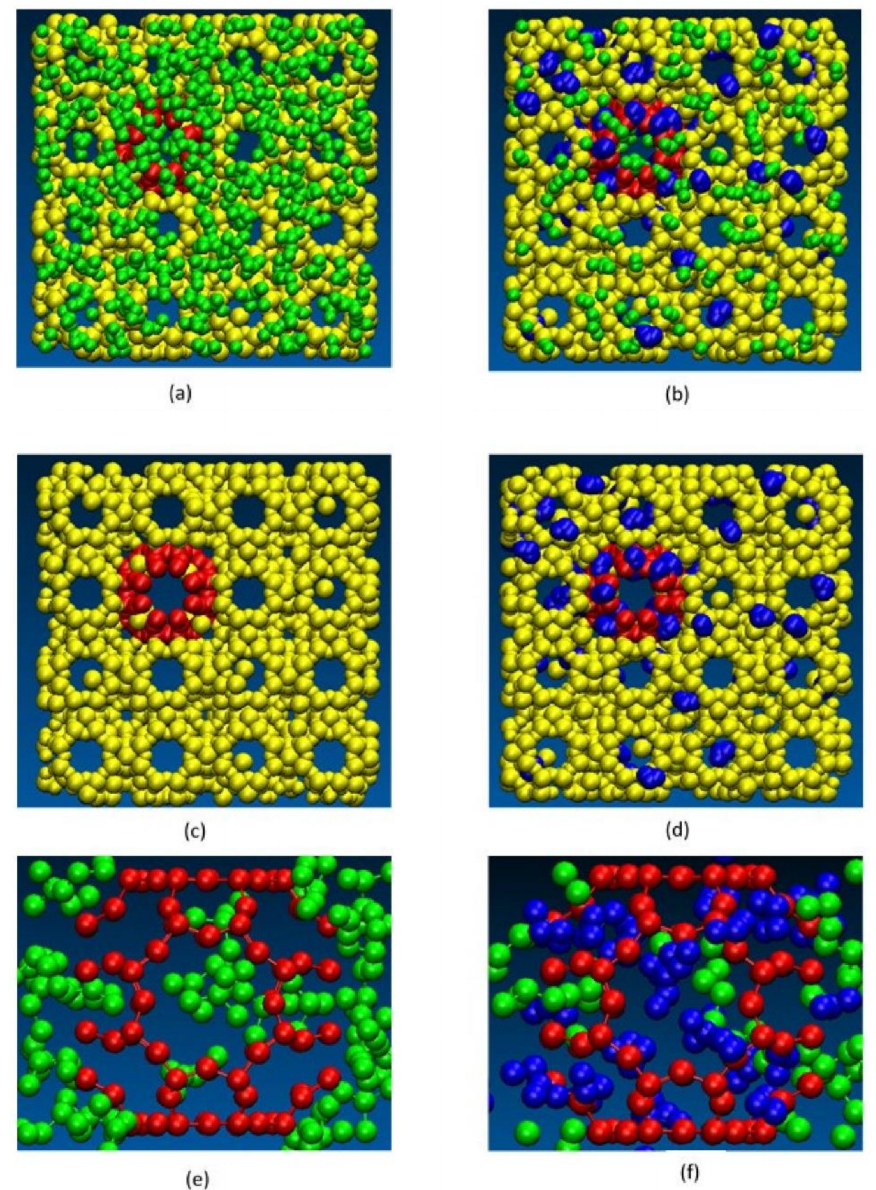
Figure 15. Changes in behavior observed in pure IPA (left side, a , c , e ) and 5 wt % water (right side, b , d , f ): axial snapshots of the membrane defect showing ( a ) pure IPA molecules permeating membrane defect and ( b ) water and IPA molecules blocking the membrane defect (water in blue); ( c ) as ( a ) above but IPA molecules removed; ( d ) as ( b ) above but IPA molecules removed; ( e ) cross section views showing pure IPA in cavity and ( f ) cross sectional view of both water and IPA molecules in cavity. The molecular diameters shown in the figure as spheres are not to